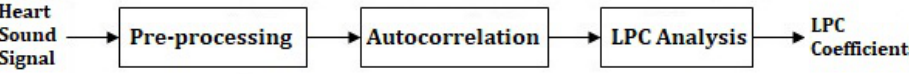
Figure 2. Block diagram for the calculation of the Linear Predictive Coding (LPC)